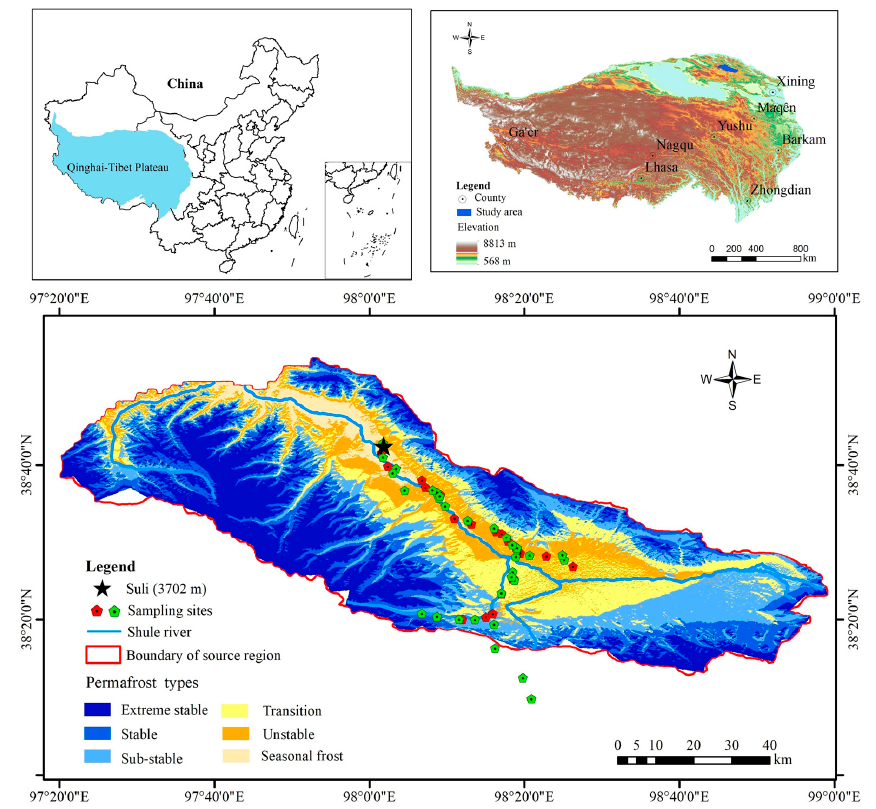
Figure 1. Source region of the Shule River Basin and its location on the Qinghai-Tibetan Plateau, China. Red pentagrams are 21 sites to perform simultaneously aerial photographing and field sampling, and green pentagrams are the other 34 sites with only aerial photographing. Table 1. The characteristics of different permafrost types in the source region of Shule River Basin [40].